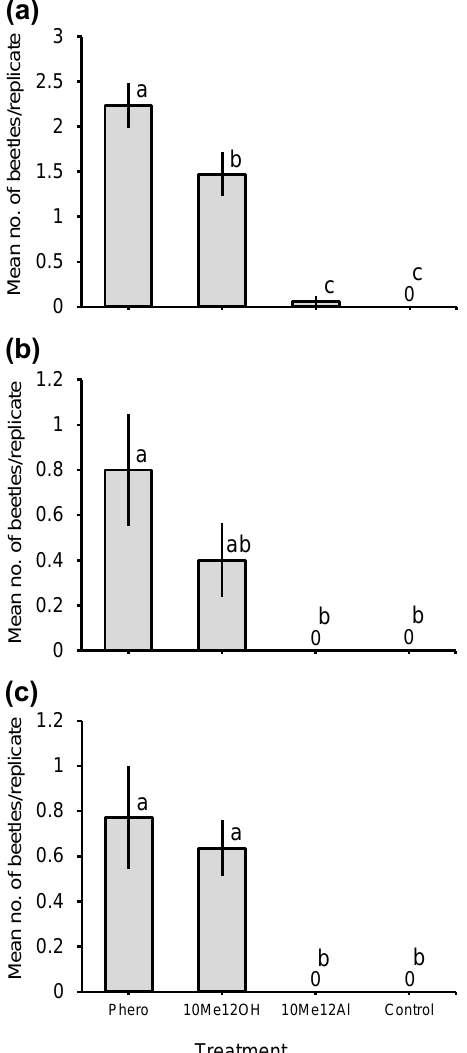
Figure 7. Mean ( ± 1 SE) numbers of adult males and females of ( a ) Compsibidion graphicum , ( b ) Compsibidion sommeri and ( c ) Tetraopidion mucoriferum caught during bioassays in Piracicaba in 2019. Treatments: Phero = 5:100 blend of racemic 10-methyldodecanal and 10-methyldodecanol (approximate ratio produced by adult males of both Compsibidion species); 10Me12OH = racemic 10-methyldodecanol; 10Me12Al = racemic 10-methyldodecanal; and Control = neat isopropanol. Means related to the same species capped by different letters are significantly different (REGWQ multiple range test: p ≤ 0.05).